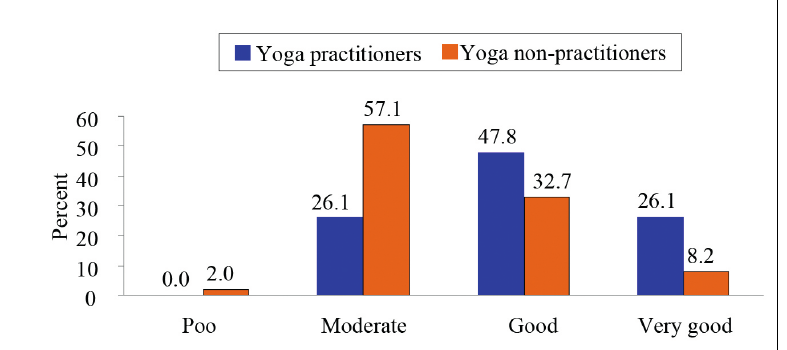
Note. x ² = 8, df = 3, p <